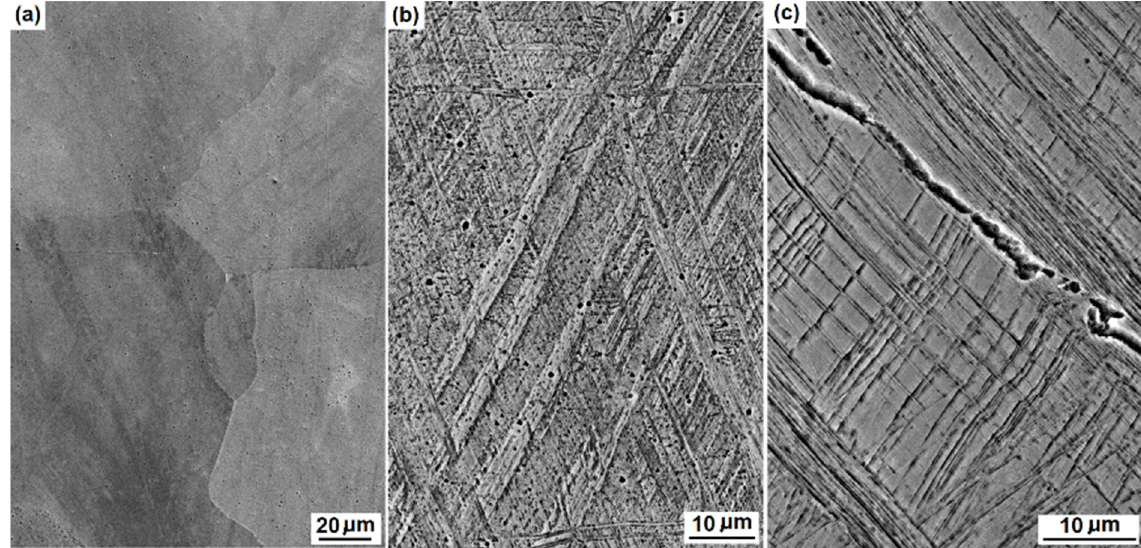
Figure 2. The microstructure of Hadfield steel under various strained conditions: ( a ) the bulk steel; ( b ) the 47%-elongated tensile bar; and ( c ) the worn top of turnout.